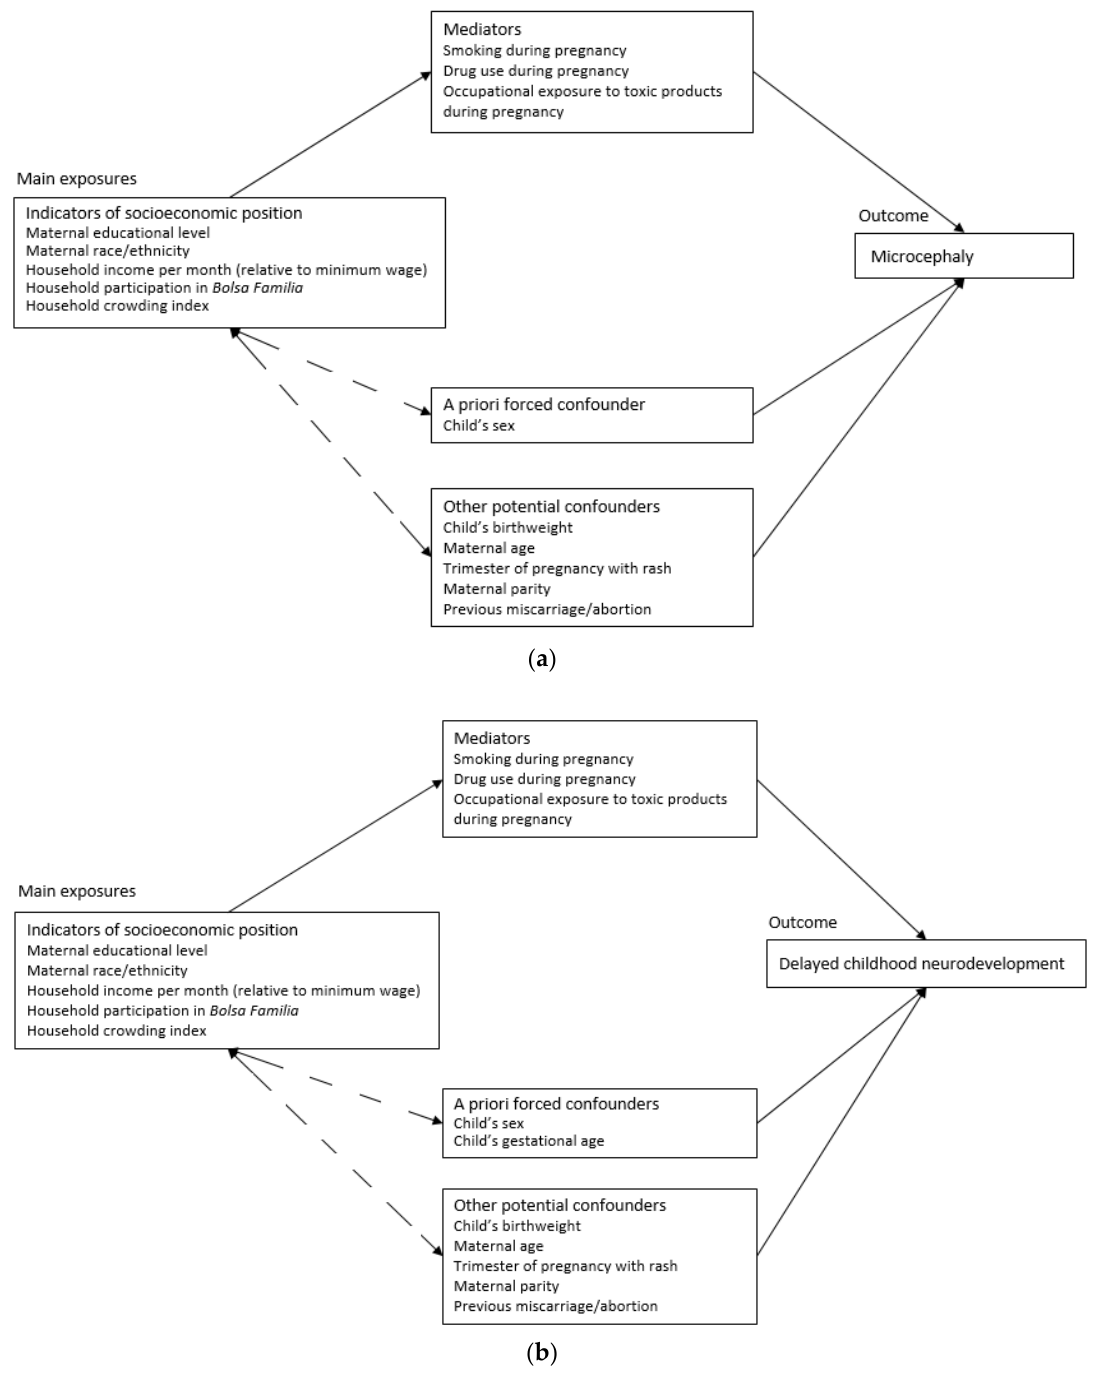
Figure 1. Conceptual frameworks for the association between the exposures of interest; social determinants and the outcomes; microcephaly ( a ) and delayed neurodevelopment ( b ) following in utero exposure to ZIKV.